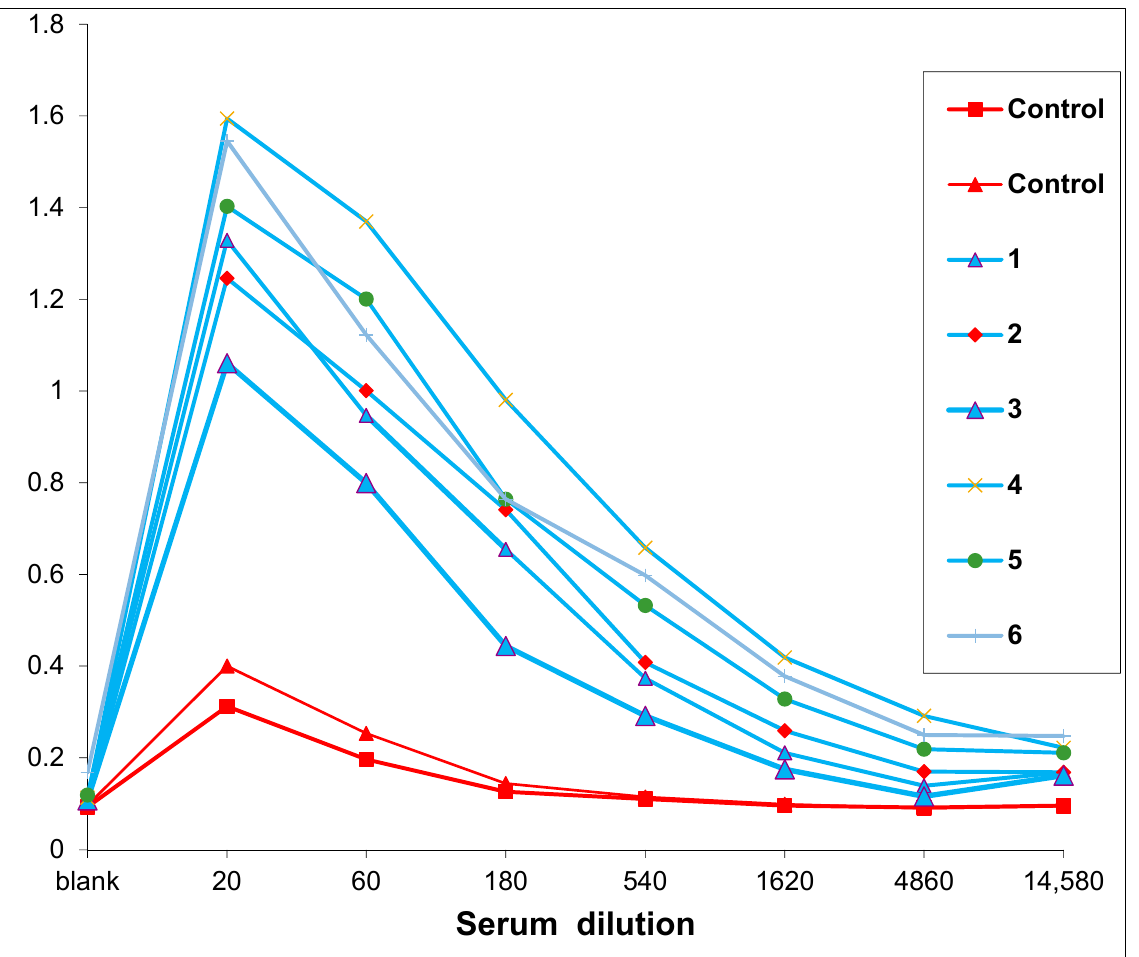
Figure 2. Antibodies against homologous virus measured in ELISA in serum of mice infected with 10 1 EID 50 of R5p. Blue curves show levels of signal for 6 infected mice. Red curves show levels of signal for 2 non-infected mice. The first point in all curves shows signals in control well (column H without virus, see Section 2.13). Table 3. Effect of Gly140Arg amino acid substitution in HA1 on pathogenicity in